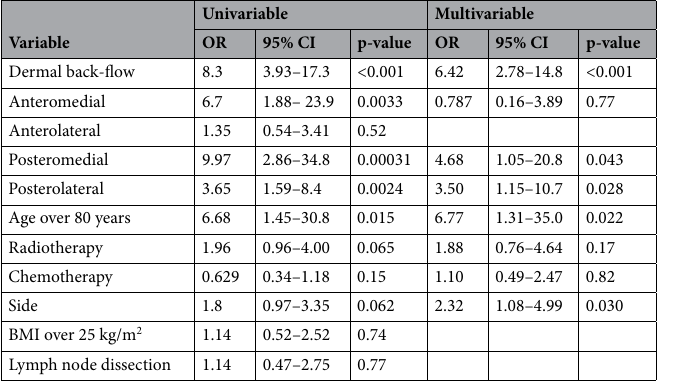
Table 4. Univariable and multivariable predictors of lymphedema